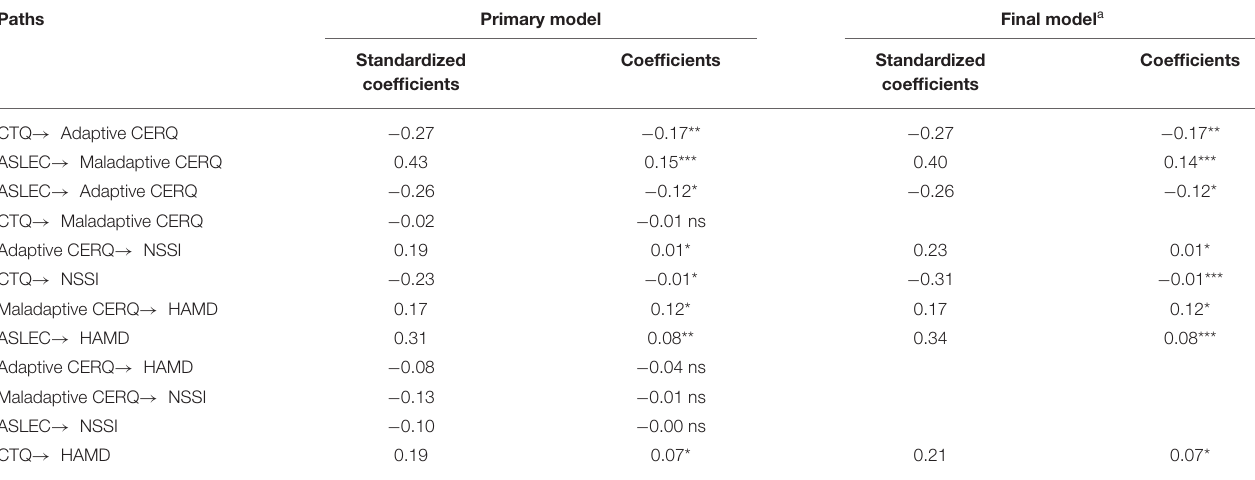
TABLE 4 | Coefficients for direct relations among childhood maltreatment, stressful life event, cognitive emotion regulation strategies, NSSI, and depression in the structural equation model.